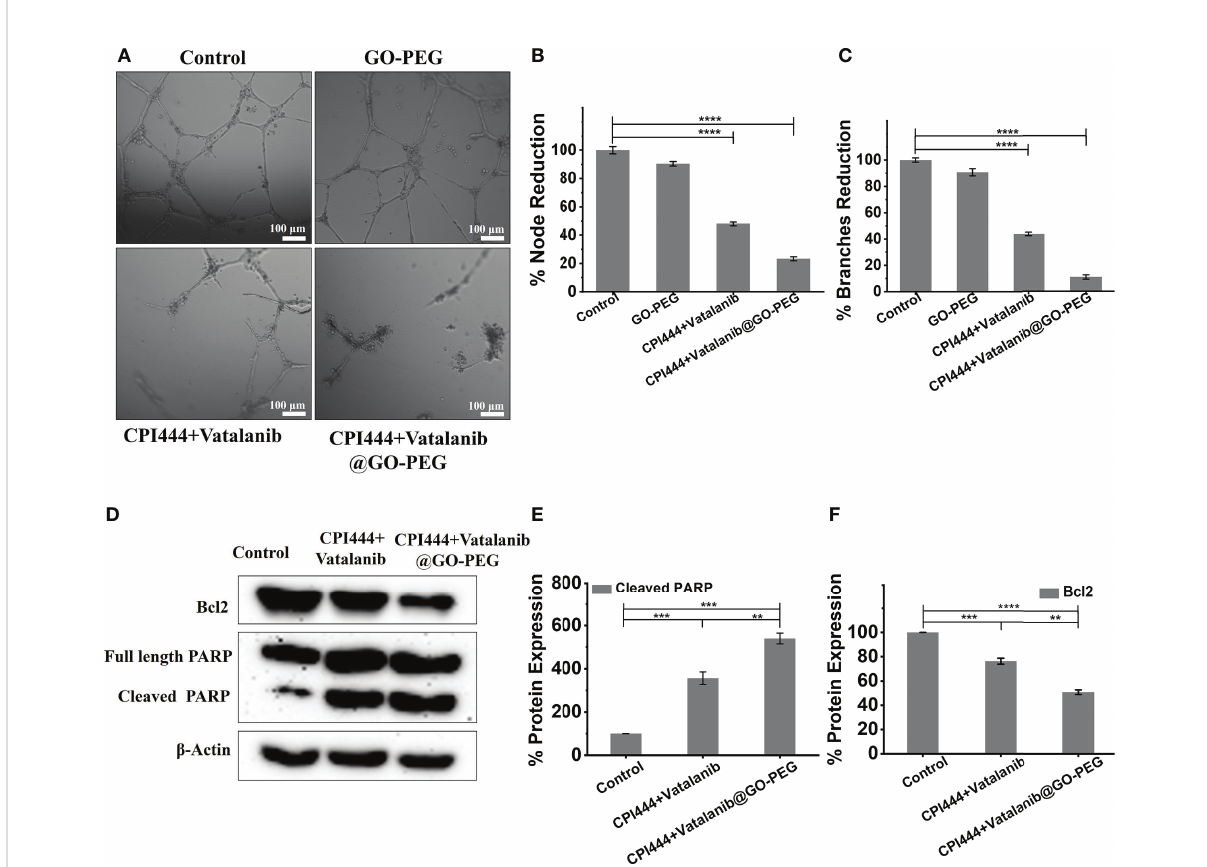
FIGURE 9 Treatment of CPI444 and vatalanib-loaded GO-PEG inhibits the angiogenic potential and causes apoptosis of GBM U87. (A – C) A tube formation assay was performed for angiogenesis analysis in GBM cells. GBM U87 cells showed a smaller number of nodes and branches compared to control cells. (D – F) Western blot analysis of Bcl2, intact PARP, cleaved PARP. b -actin was used as an internal control. The Western blot shown is a representative of three independent experiments. **** p < 0.0001, *** p < 0.001, and ** p <